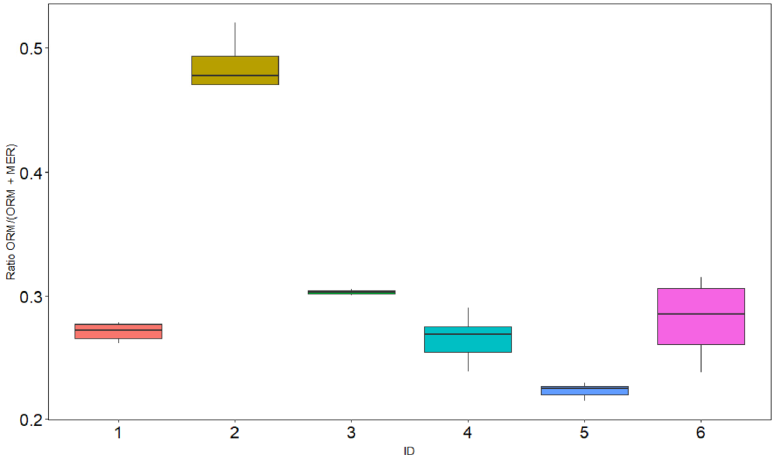
Figure 3. Intra- and interindividual variability of the ratio of the open-ring metabolite (ORM) to the total meropenem concentration in six critically ill patients.